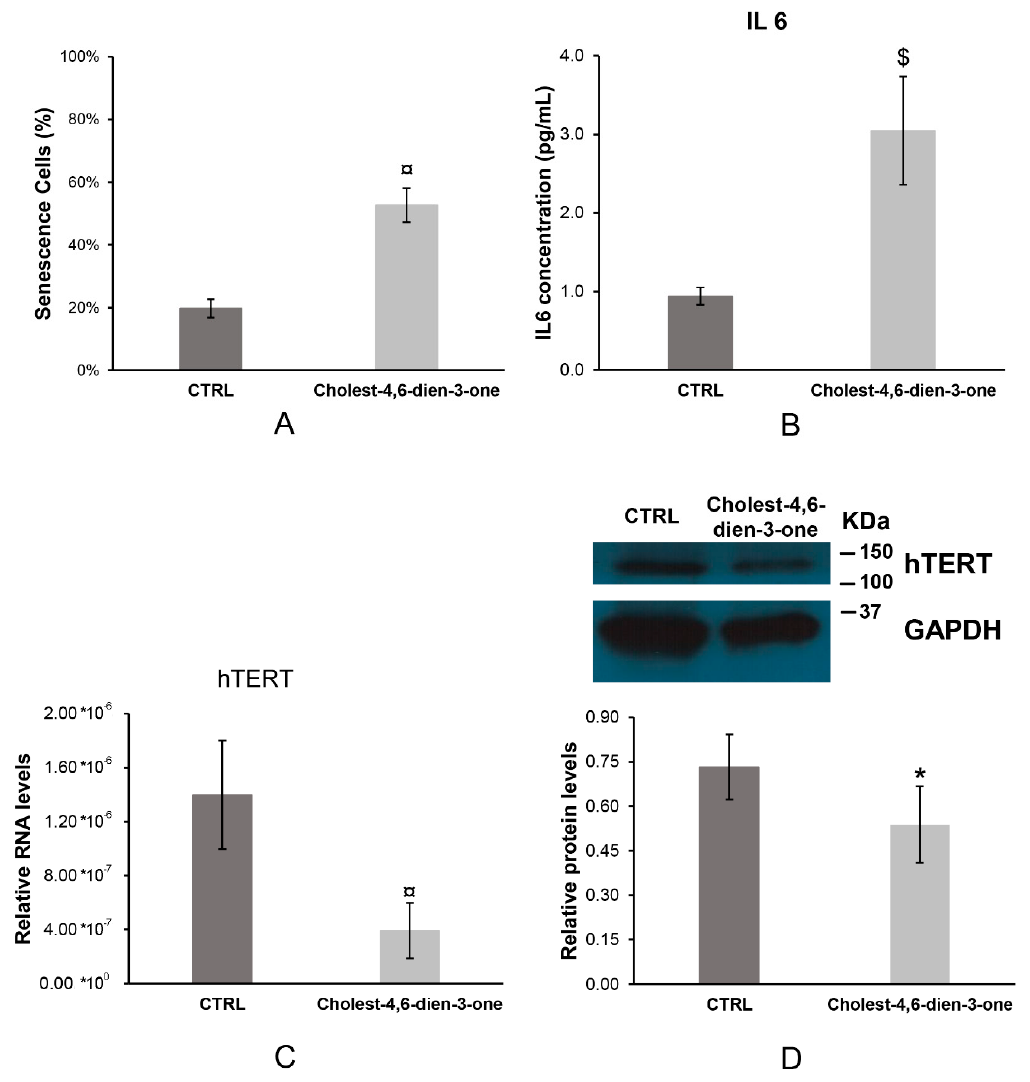
Figure 2. Cholest-4,6-dien-3-one induced cell senescence, impoved IL6 secretion and decreased relative mRNA and protein expression of hTERT. ( A ) Cell senescence in cultures determined by XGAL assay of hBTSCs cultured in KM added with cholest-4,6-dien-3-one or basal condition (KM). ( B ) IL-6 concentration in growth medium measured by ELISA of hBTSCs cultured in KM added with cholest-4,6-dien-3-one or basal condition (KM). ( C ) Relative hTERT RNA levels of expression analyzed by RT-qPCR of hBTSCs cultured in KM added with cholest-4,6-dien-3-one or basal condition (KM). ( D ) Relative hTert protein levels expression analyzed by Western blot of hBTSCs cultured in KM added with cholest-4,6-dien-3-one or basal condition (KM). Data expressed as mean ± SD of N = 6 experiments; * p < 0.05; $ p < 0.001; ¤ p <